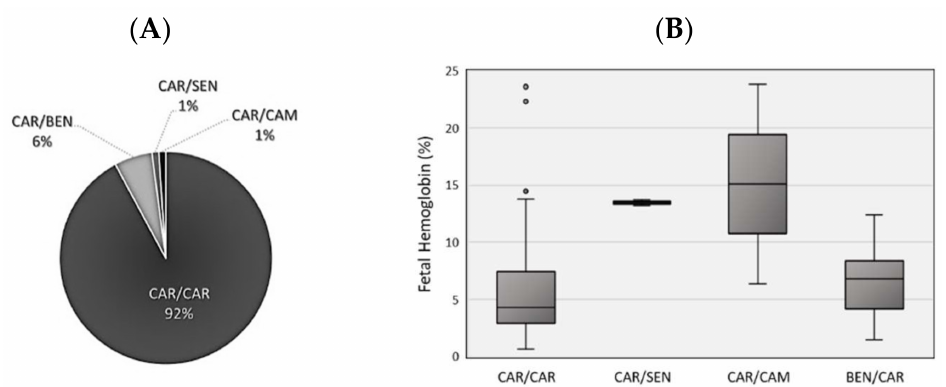
Figure 2. ( A ) Frequency of HBB haplotypes in the studied SCA population; ( B ) Distribution of HbF levels at different haplotype groups. Lines of the boxes represent the lower quartile, median, and upper quartile, and the outliers are the points outside the whiskers.